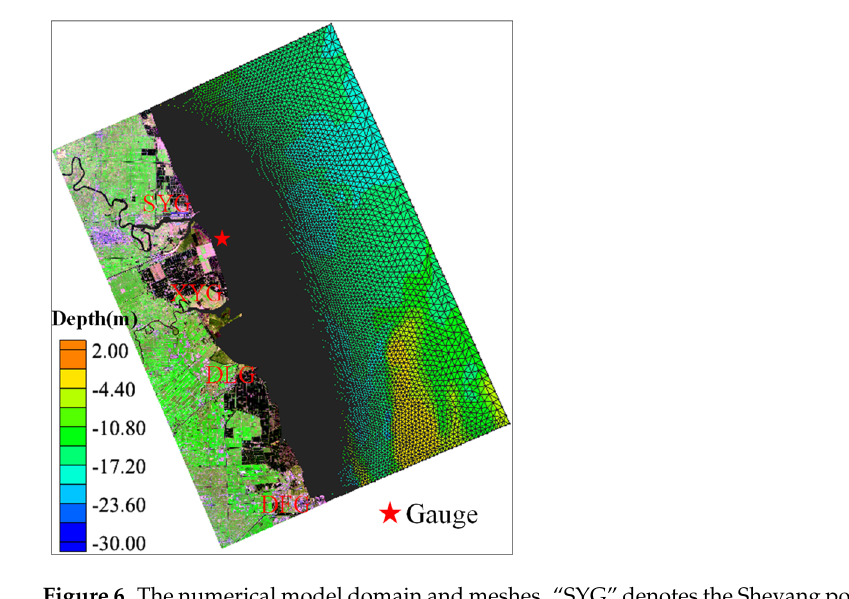
Figure 6. The numerical model domain and meshes. “SYG” denotes the Sheyang port, “XYG” denotes Xinyanggang, and “DLG” denotes Doulonggang and “DFG” denotes